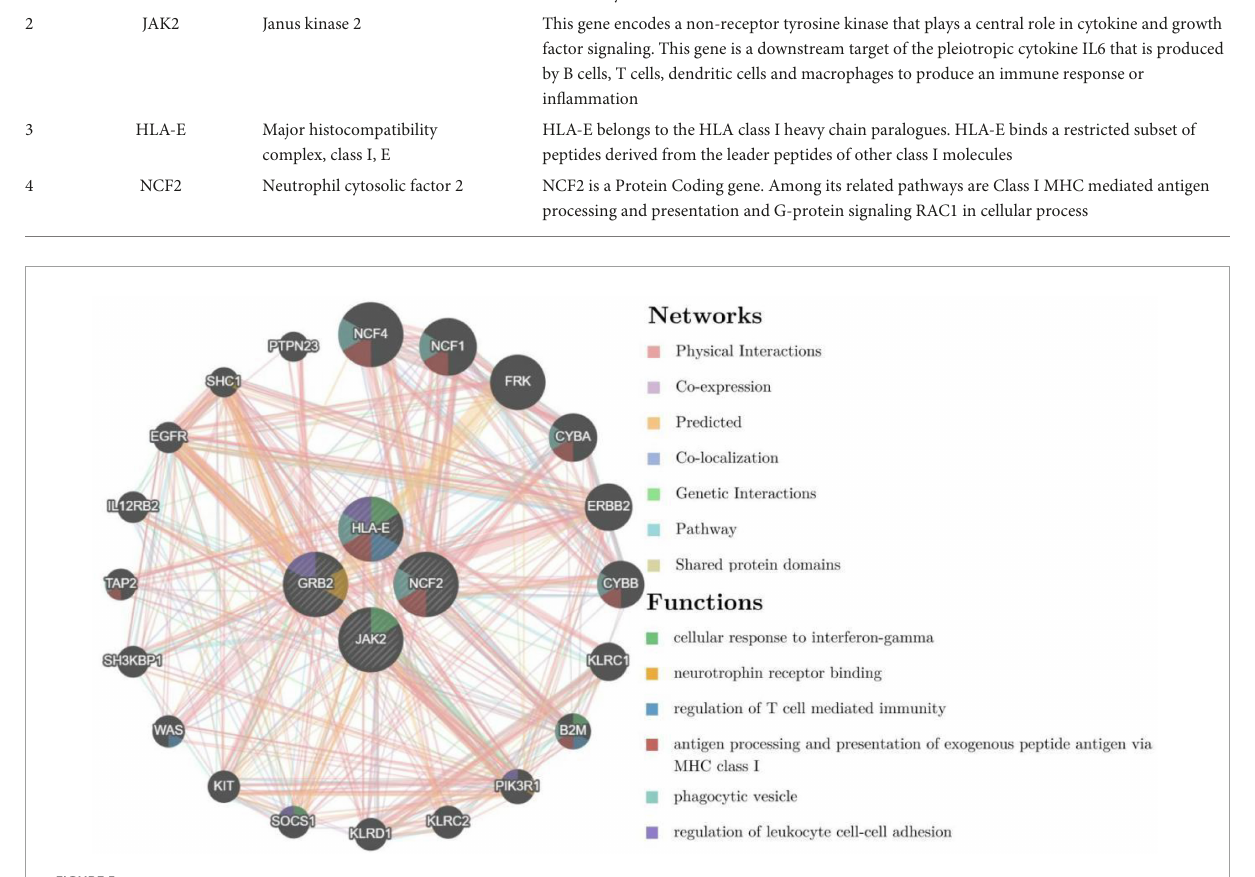
FIGURE5 Co-expression network of critical hub